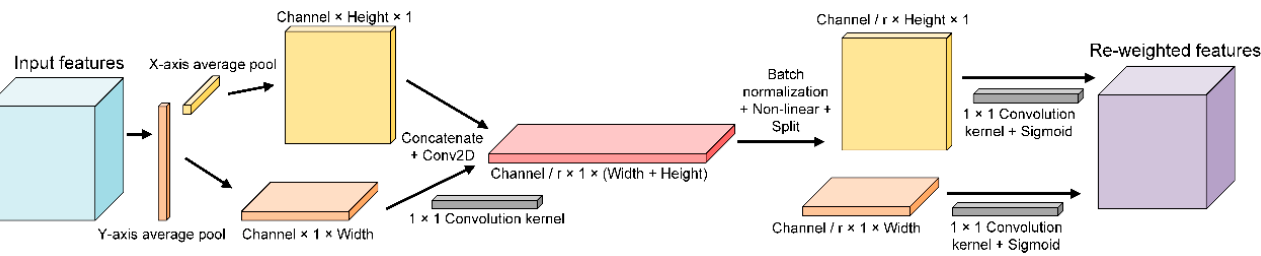
Figure 4. Implementation of the coordinate attention.